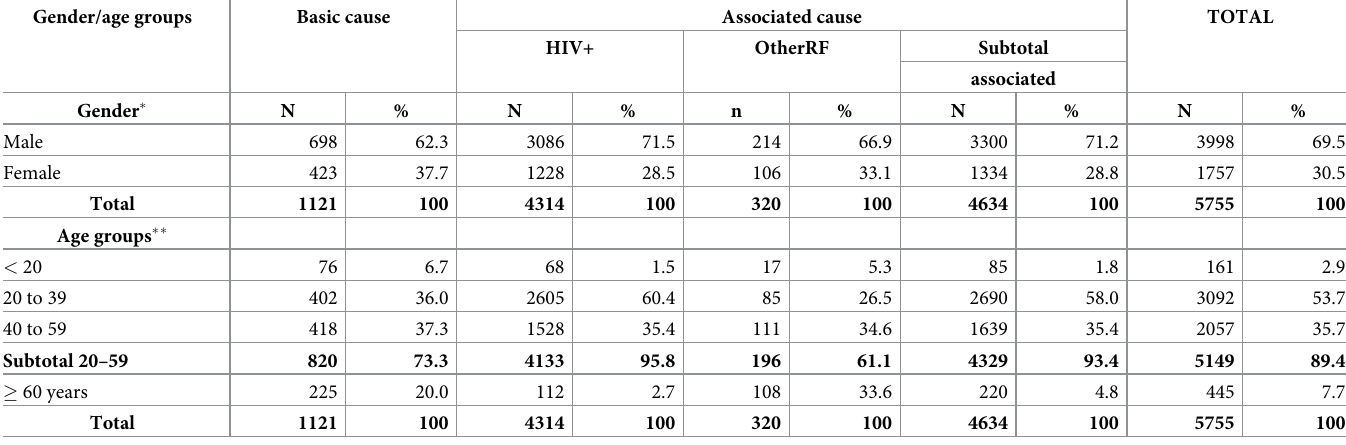
Table 1. Cryptococcosis deaths by gender and age groups, by basic and associated cause. Brazil, 2000 to 2012. Gender/age groups Basic